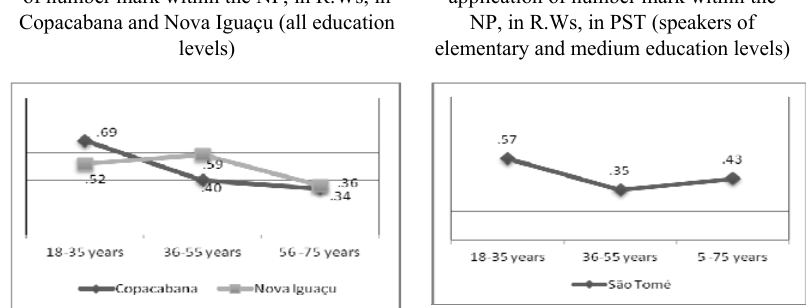
Figure 9. Actuation of age for the application of number mark within the NP, in R.Ws, in Copacabana and Nova Iguaçu (all education